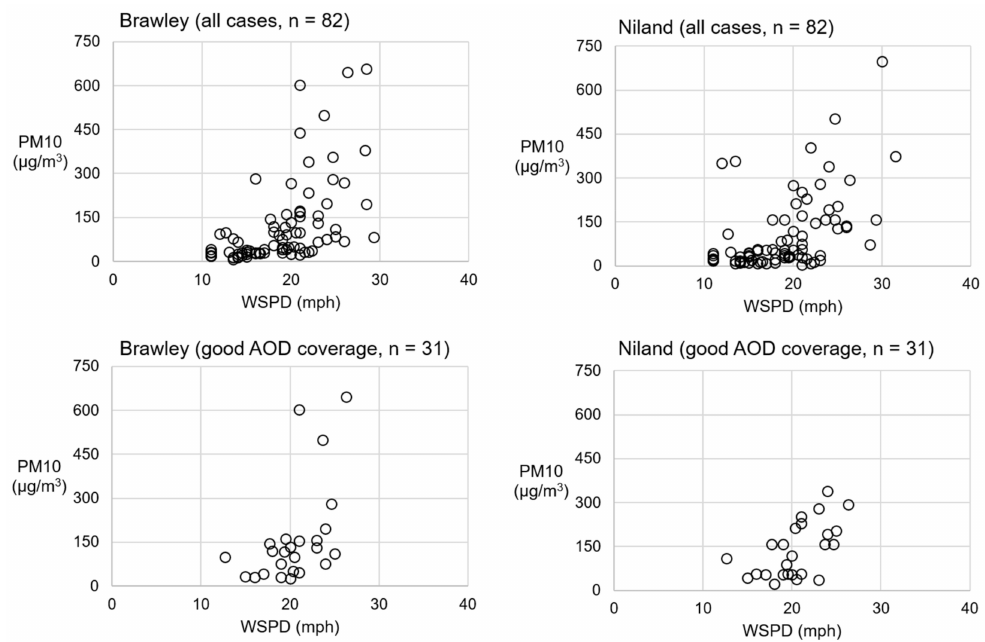
Figure A1. PM10 concentrations averaged over 1200 to 1400 LST at Brawley ( left panels ) and Niland-English Road ( right panels ) versus wind speed at KIPL averaged over 1200 to 1400 LST for days screened for wind speeds greater than 10 miles per hour and wind direction between 230 and 280 degrees. The top panels are all screened days and the bottom panels are subset for which AOD spatial coverage was deemed su ffi cient for final